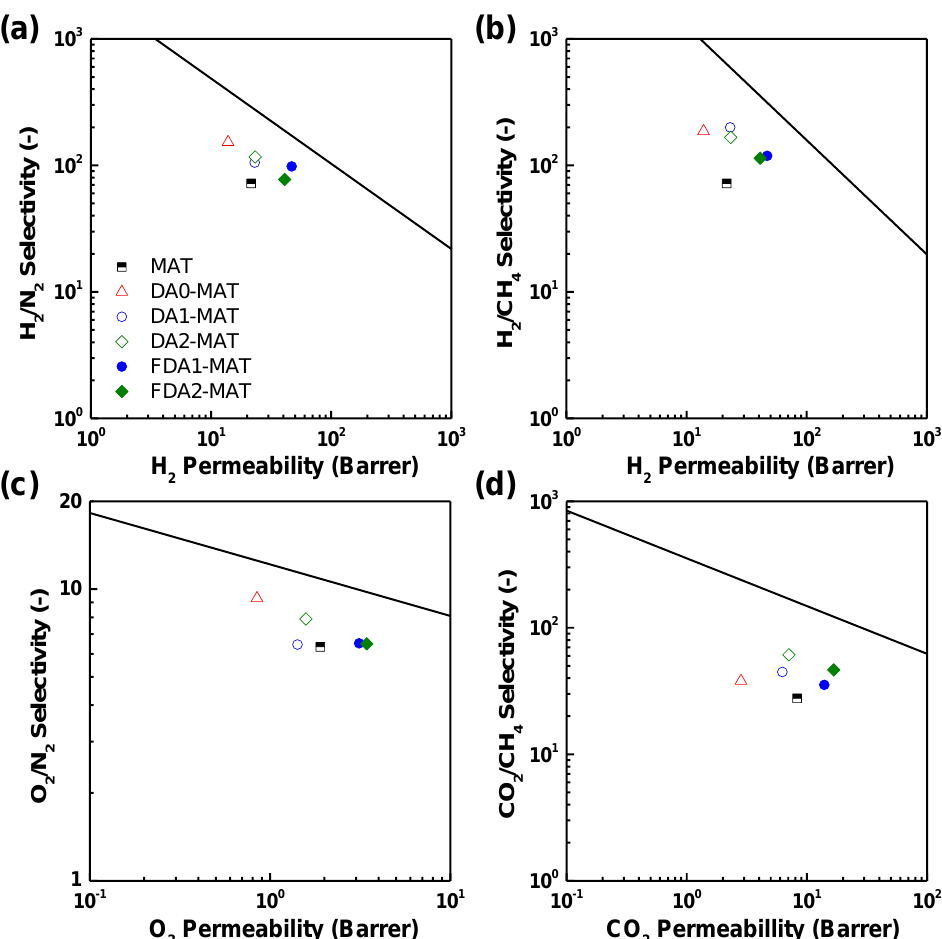
Figure 6. Gas separation performance of diamine-modified Matrimid membranes for ( a ) H 2 /N 2 , ( b ) H 2 /CH 4 , ( c ) O 2 /N 2 , and ( d ) CO 2 /CH 4 gas pairs measured at 2 bar and 35 °C. Black solid lines represent the 2008 Robeson upper bound for polymer membranes [46]. Table 3. Comparison of CO 2 /CH 4 separation performance of amino-modified polyimide mem- branes.